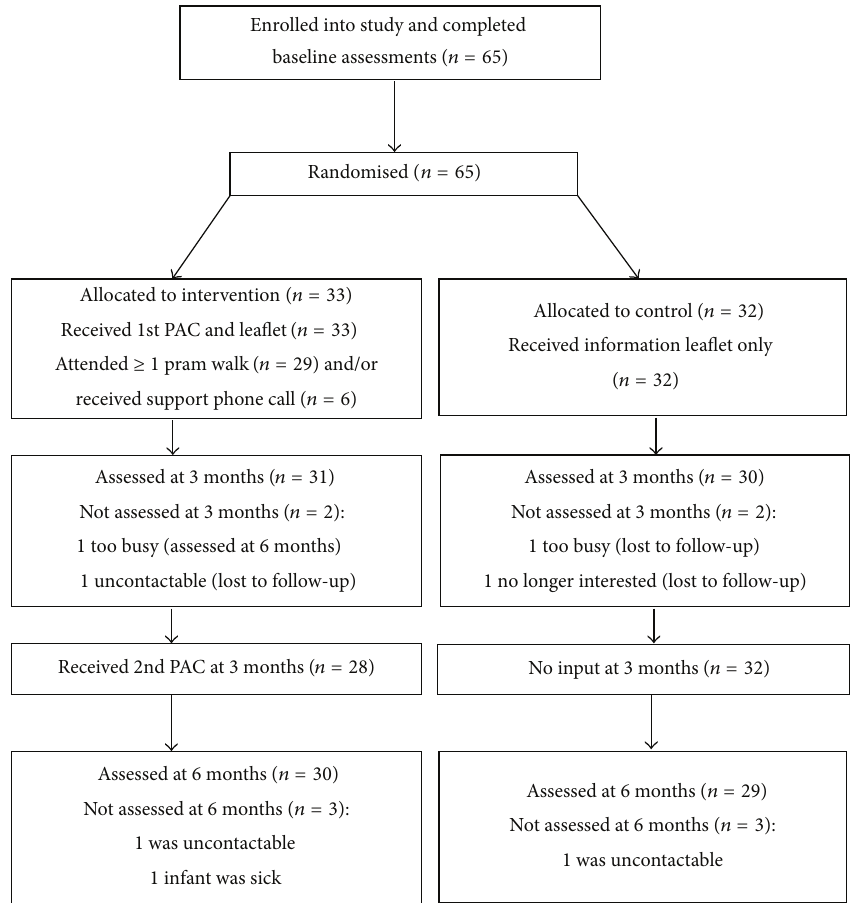
Figure 1: Flow of participants through the MAMMiS study.